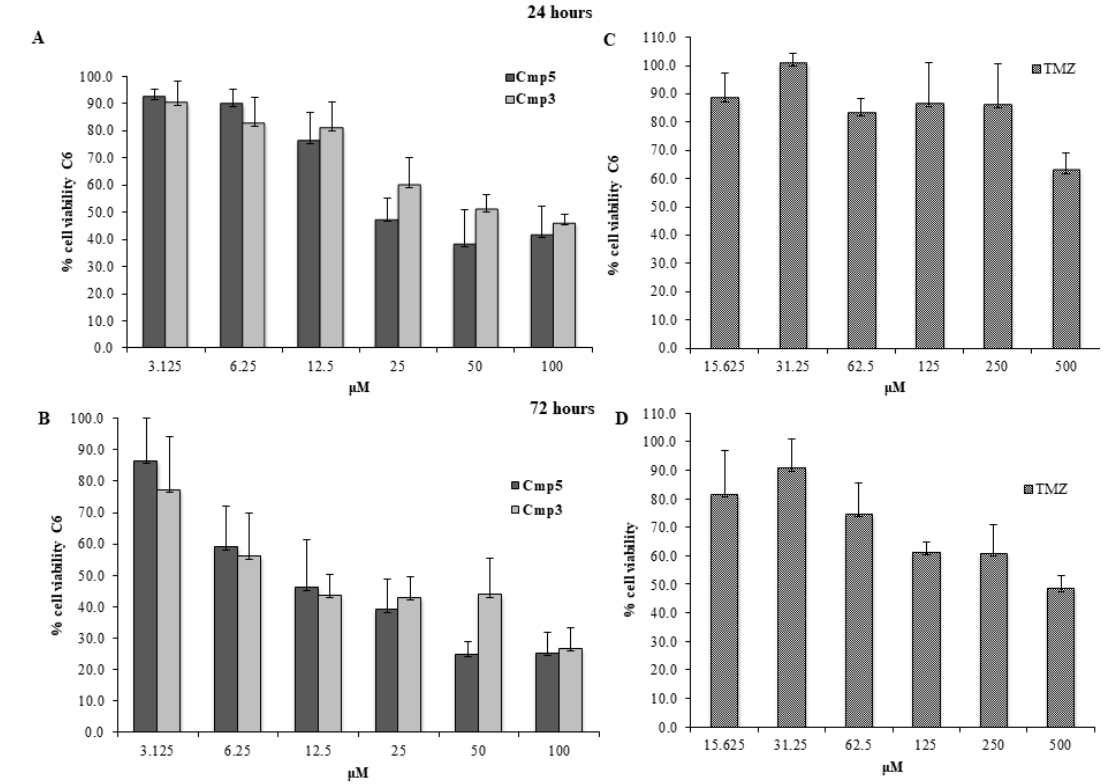
Figure 3. MTT cell viability assay on C6. ( A,B ) Histograms represent the viability dose-response of C6 cells exposed to di ff erent concentrations of Cmp 3 and Cmp 5 (from 3.125 to 100 µ M) for 24 h and 72 h. ( C,D ) Histograms represent the viability dose-response of C6 cells exposed to di ff erent concentrations of TMZ (from 15.636 to 500 µ M) for 24 h and 72 h. Proliferation was assessed using MTT assay and normalized to control cells treated with DMSO (0.2% as final